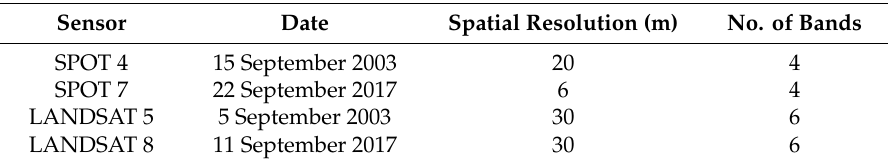
Table 1. List of satellite images used in the